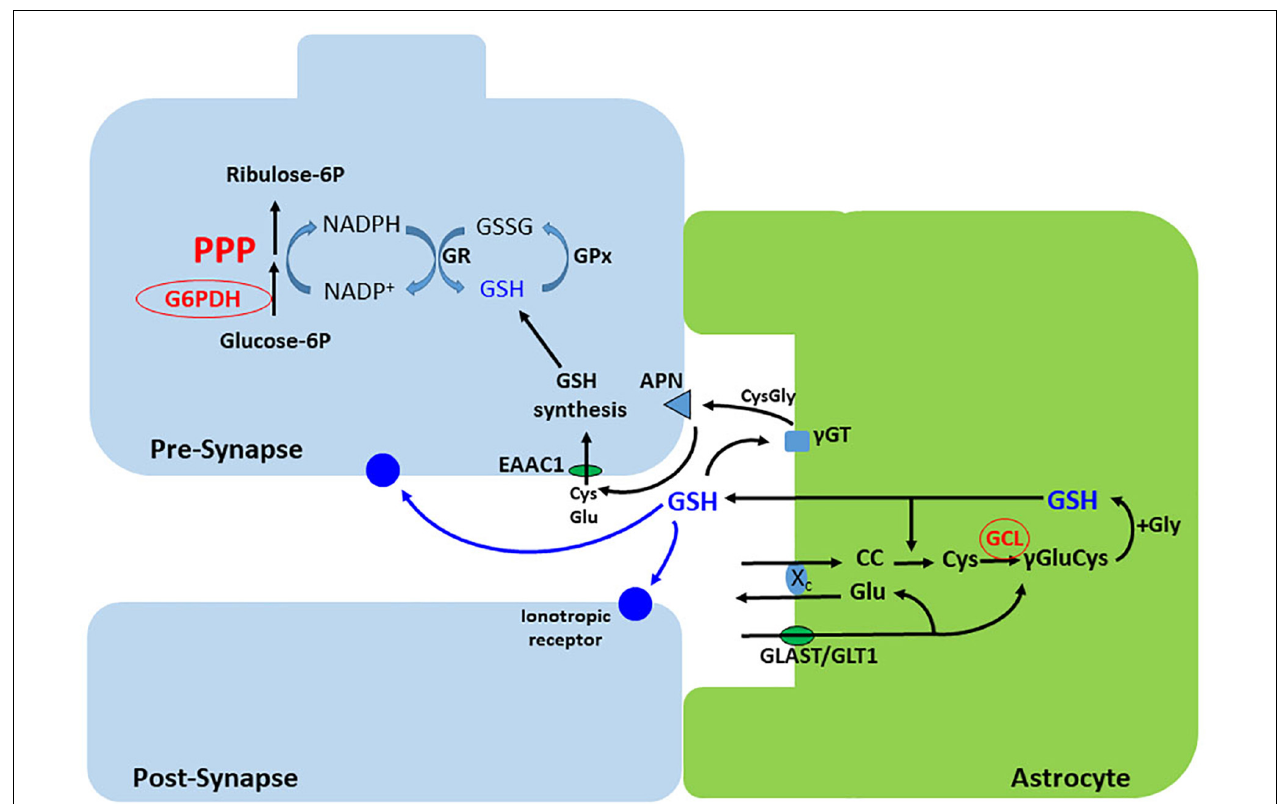
FIGURE 4 | Synthesis and release of GSH in astrocytes. Cystin (cisteinyl-cystein, CC) is uptaken via the xc - exchanger, which releases glutamate. This exchanger is functionally coupled to the Na + - dependent glutamate transporters, GLAST or GLT-1. Cystin is reduced by GSH to two cysteines. The gamma acid group of glutamate then condenses with the amine group of cysteine, forming gamma-glutamyl-cysteine ( γ Glu-Cys), by the action of the glutamate cysteine ligase (GCL). Addition of glycine completes the synthesis of GSH that, in part, is exported to modulate ionotropic receptors and as a source of cysteine for GSH synthesis in neurons. The extracellular cysteine from astroglial GSH is generated after sequential action of the extracellular peptidases, γ GT and APN. Neurons synthesize low levels of GSH compared with astrocytes, but exhibit a high capacity of GSH regeneration, which depends on NADPH synthesis in the PPP. γ GT, gamma peptidyl transpeptidase; APN, aminopeptidase neuronal; GPx, glutathione peroxidase; GR, glutathione reductase; EAAC, excitatory amino acid carrier.